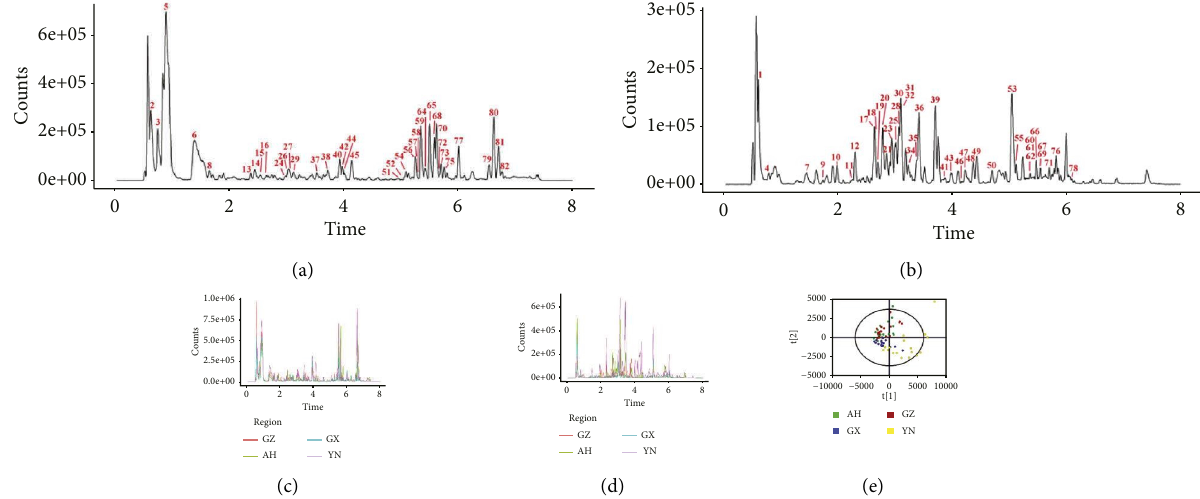
Figure 2: Profle analysis of secondary metabolomics of D. ofcinale in diferent regions. Te quality control and typical base peak chromatogram of D. ofcinale in positive ion mode (a, c) and negative ion mode (b, d). PCA score plot of D. ofcinale from four regions Table 2: Secondary metabolites of D. ofcinale from four regions.